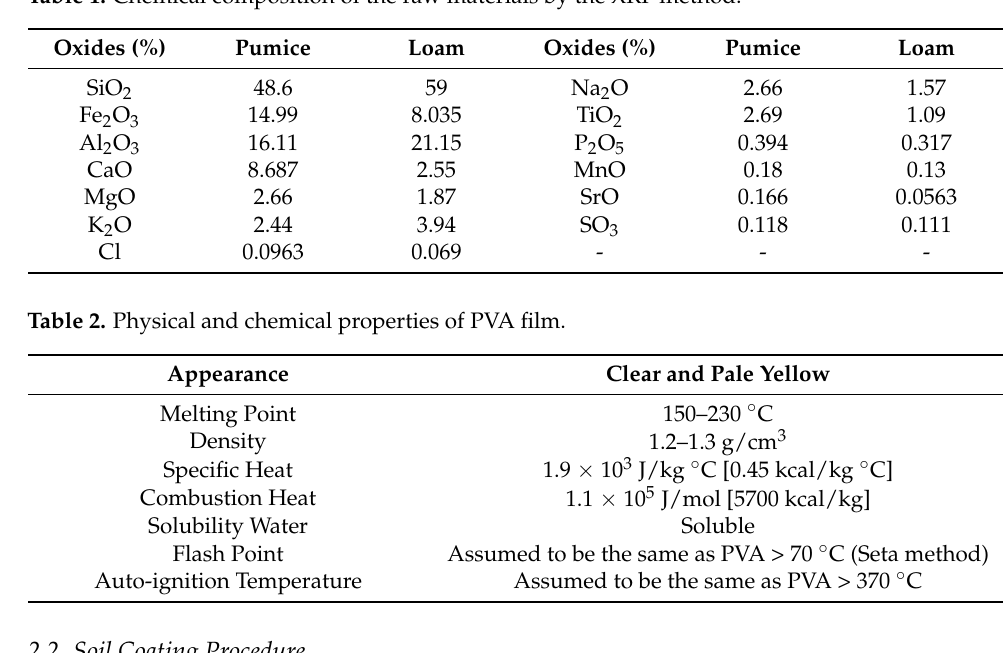
Table 1. Chemical composition of the raw materials by the XRF method.